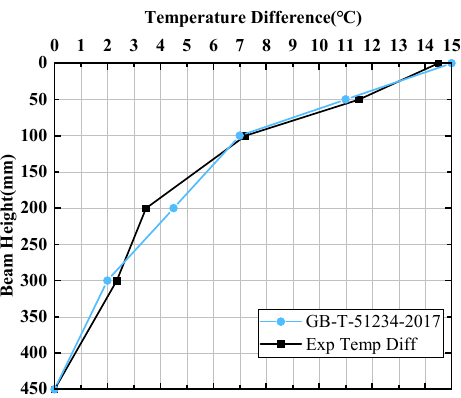
Figure 9. Comparison between measured data and exponential function curve fitting of the steel box girder.